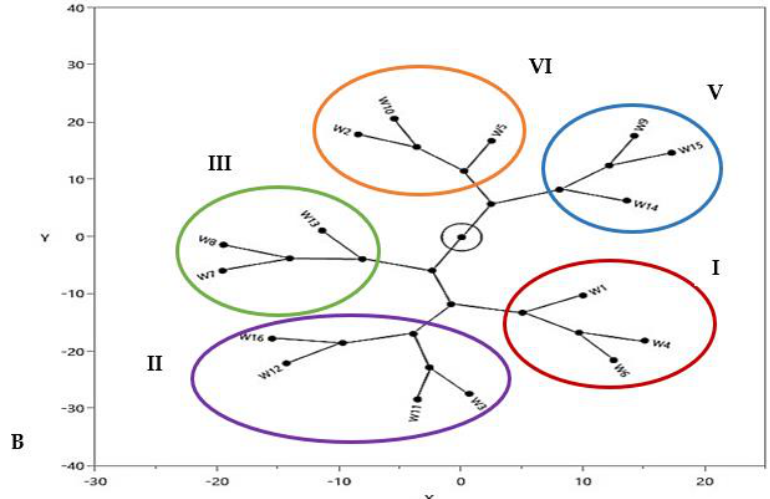
Figure 3. Clustering multivariate analysis using Ward’s method for distribution of 16 Egyptian T. aestivum genotypes based on the phenological and morphological markers by using ( A ) hierarchical co-clustering dendrogram and heatmap; row clusters were obtained at genotype level, whereas the column cluster were recorded at trait or marker level; ( B ) Constellation plot from hierarchical cluster analysis showing five clusters (Clusters I, II, III, IV and V represent clusters as red, violet, green, orange and blue oval shapes).